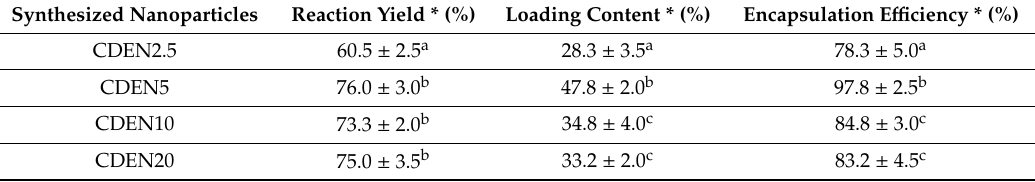
Table 1. Reaction yield, loading content, and encapsulation efficiency of the synthesized nanoparticles.